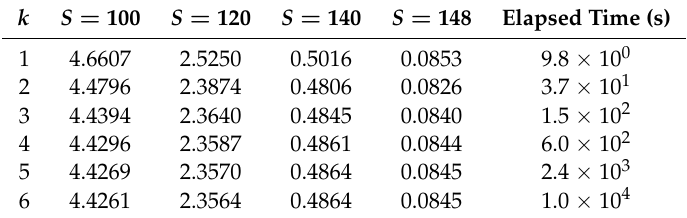
Table 5. V ( S ,0,0 ) evaluated by FD2 at S = 100,120,140,148, with ∆ S =